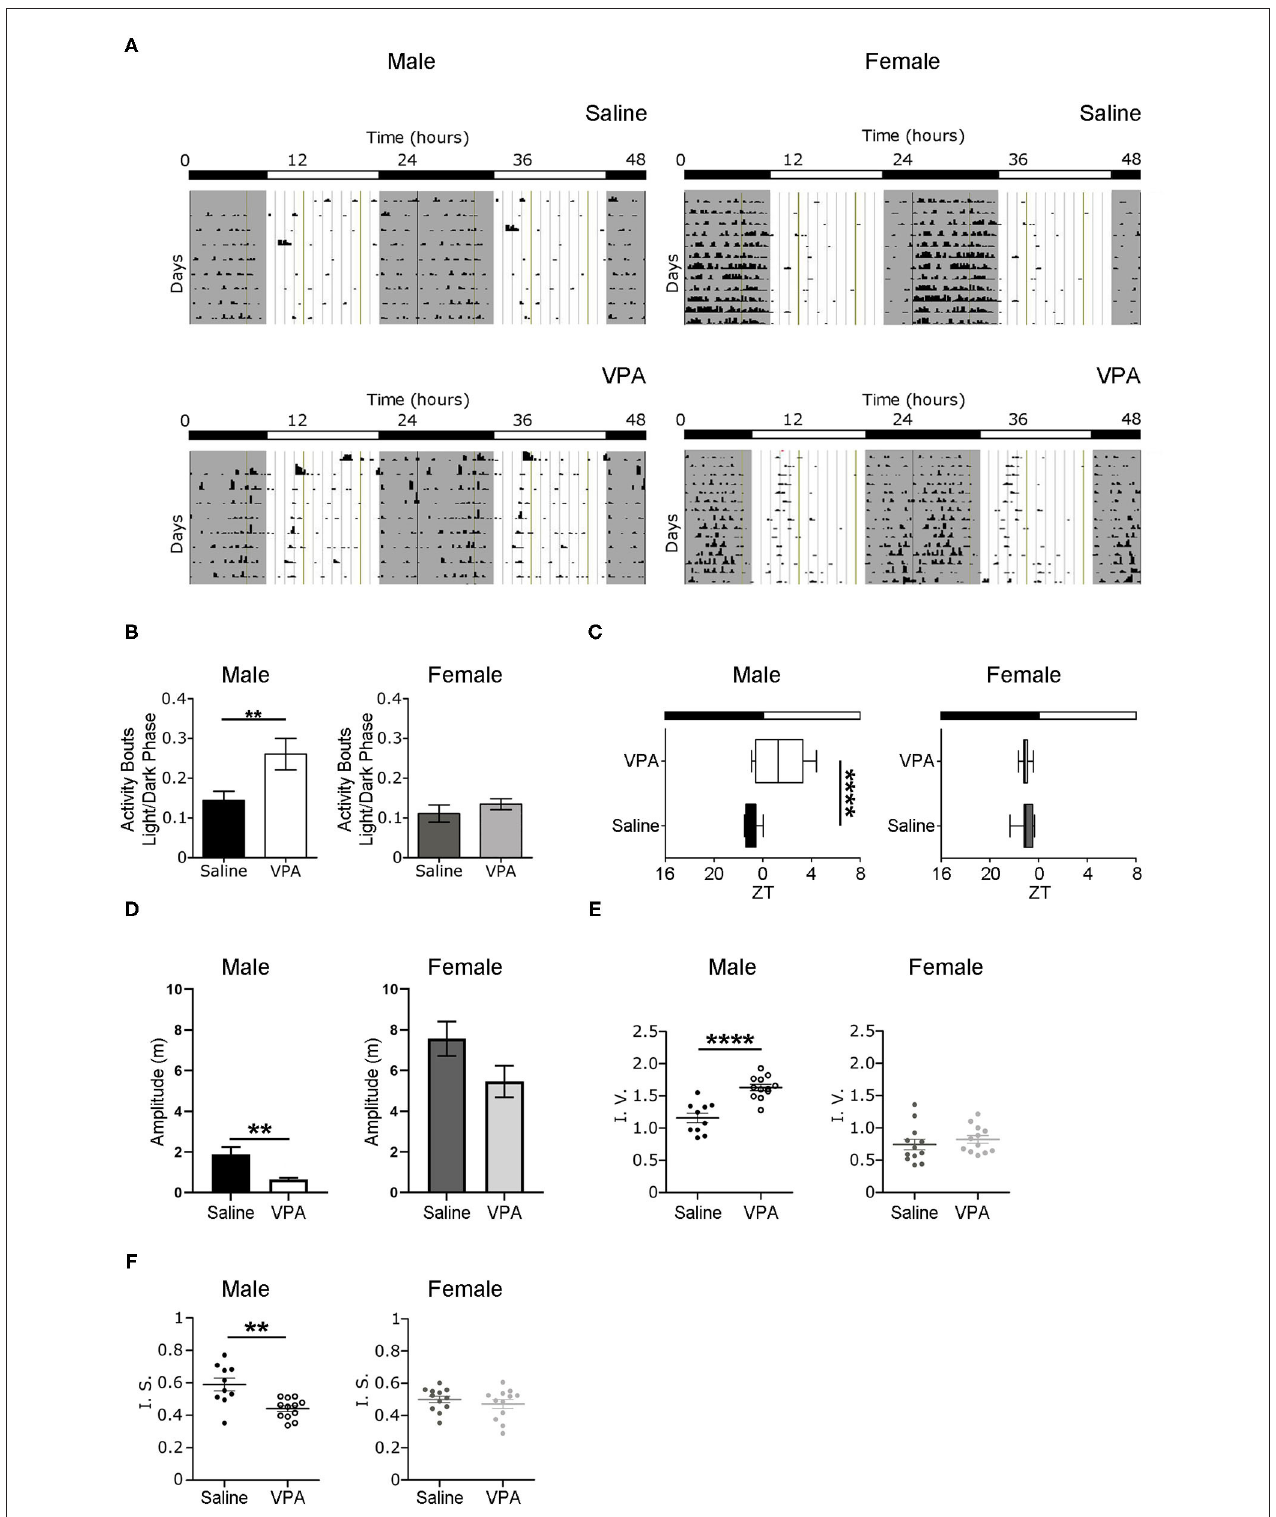
FIGURE 1 | In utero VPA exposure alters wheel-running behaviour under baseline conditions. (A) Representative double-plotted actograms from (left panel) saline-exposed males ( n = 10) and VPA-exposed males ( n = 12). Right panels represent double-plotted actograms from saline-exposed females ( n = 12)